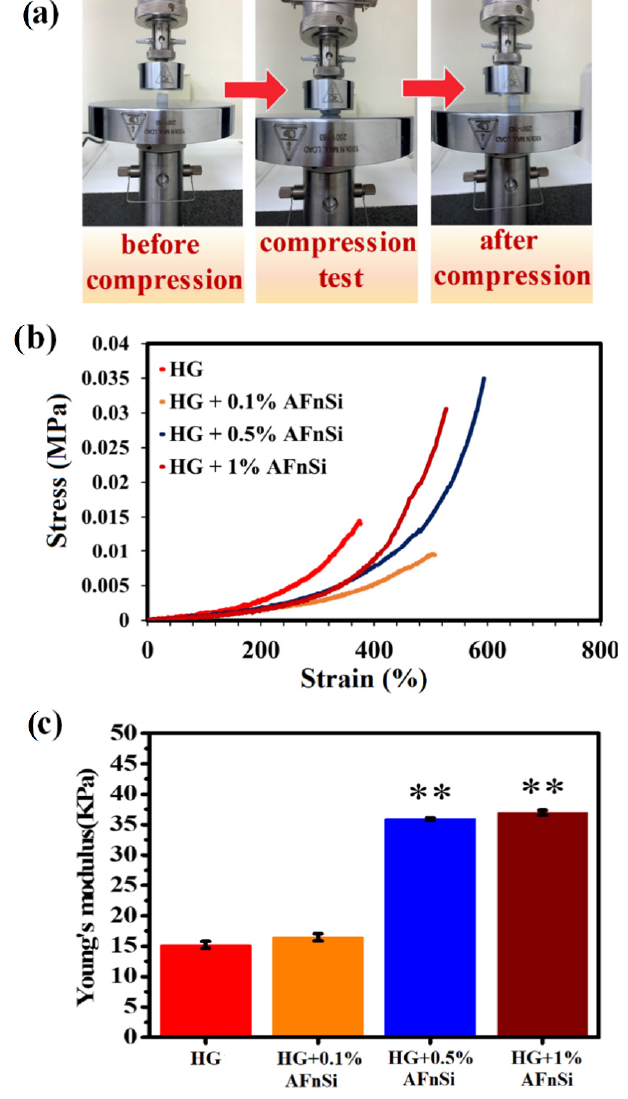
Figure 7. Compression stress-strain curves of HG hybrid hydrogels with the different concentrations of AFnSi crosslinkers (0, 0.1, 0.5, and 1.0% ( w / v )). The schematic photo of the typical compression test process for the HG hybrid hydrogels ( a ) shows the typical curves of compressive stress (kPa) vs. compressive strain (%) ( b ) and their average Young’s modulus (kPa) ( c ). Error bar represents ± SD, ** indicates the significant difference compared to HG and HG/AFnSi values at p < 0.01.